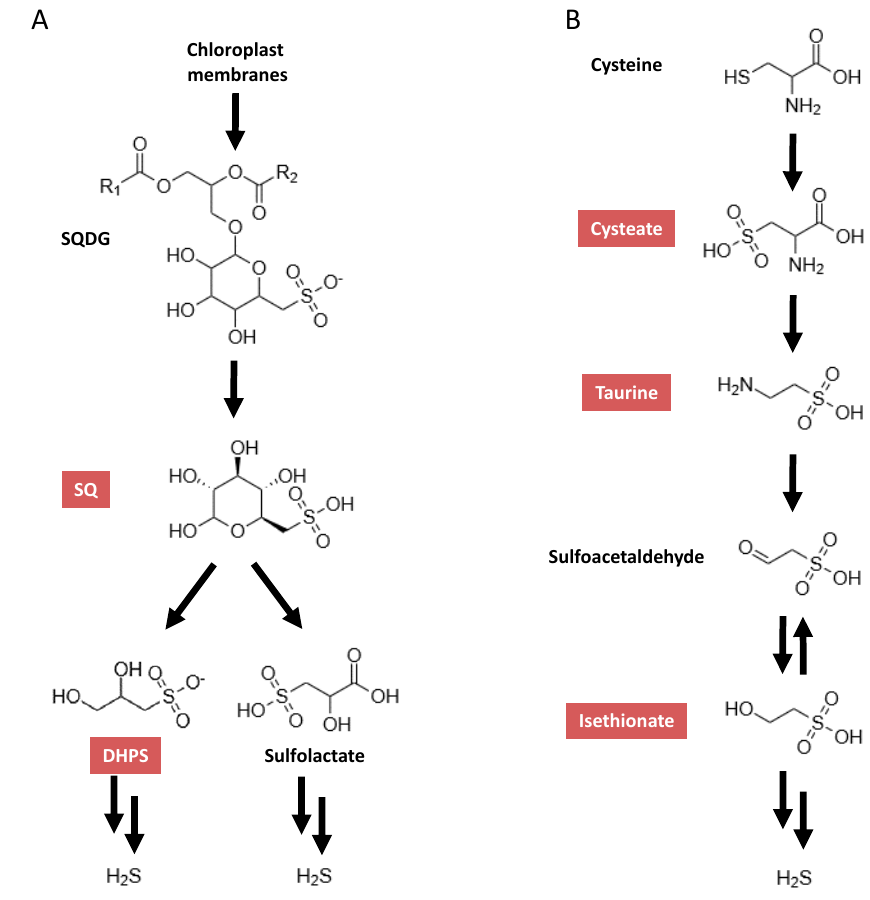
Figure 1. Simplified metabolic pathways for taurine (modified from Kyoto Encyclopedia of Genes and Genomes (KEGG) pathway map 00430) ( A ) and sulfoquinovose (modified from Denger et al. [6] and Felux et al. [16]) ( B ). SQDG, sulfoquinovosyl diacylglycerols; SQ, sulfoquinovose; DHPS, 2,3-dihydroxy-1-propanesulfonate. Compounds quantifiable by the presented method are highlighted in